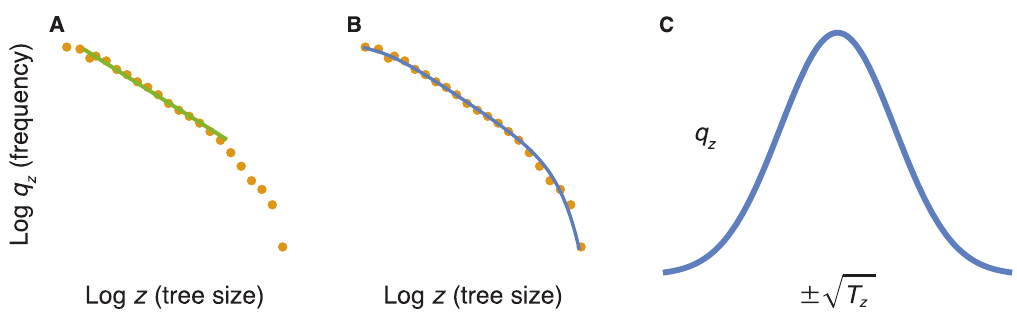
Figure 1. ( A ) Tree size, z = d 2 , in which the squared diameter, d 2 , is proportional to the cross sectional area of the stem, and d ranges over approximately 11–2800mm. The green line shows great regularity of pattern as a power law over the range that covers almost all probability. The largest trees, beyond the green power law line, comprise only a small fraction of all trees, because of the logarithmic scaling of frequency. ( B ) The blue line is log q = log k − λ T , with T = log(1 + az ) + γ z , and parameters λ = 1.06, a = 0.004, and γ = 7 × 10 − 7 , with log k shifting z z z curve height and total probability. ( C ) The fitted blue line in panel B is a classic normal distribution with variance 1 / 2 λ when plotted as q e − λ Tz versus ± , with respect to z as a positive parameter. In this plot, the metric is shifted so that the most common type associates with a z T value T = 0. Data approximated from Figure 4 in Farrior et al. 1 z